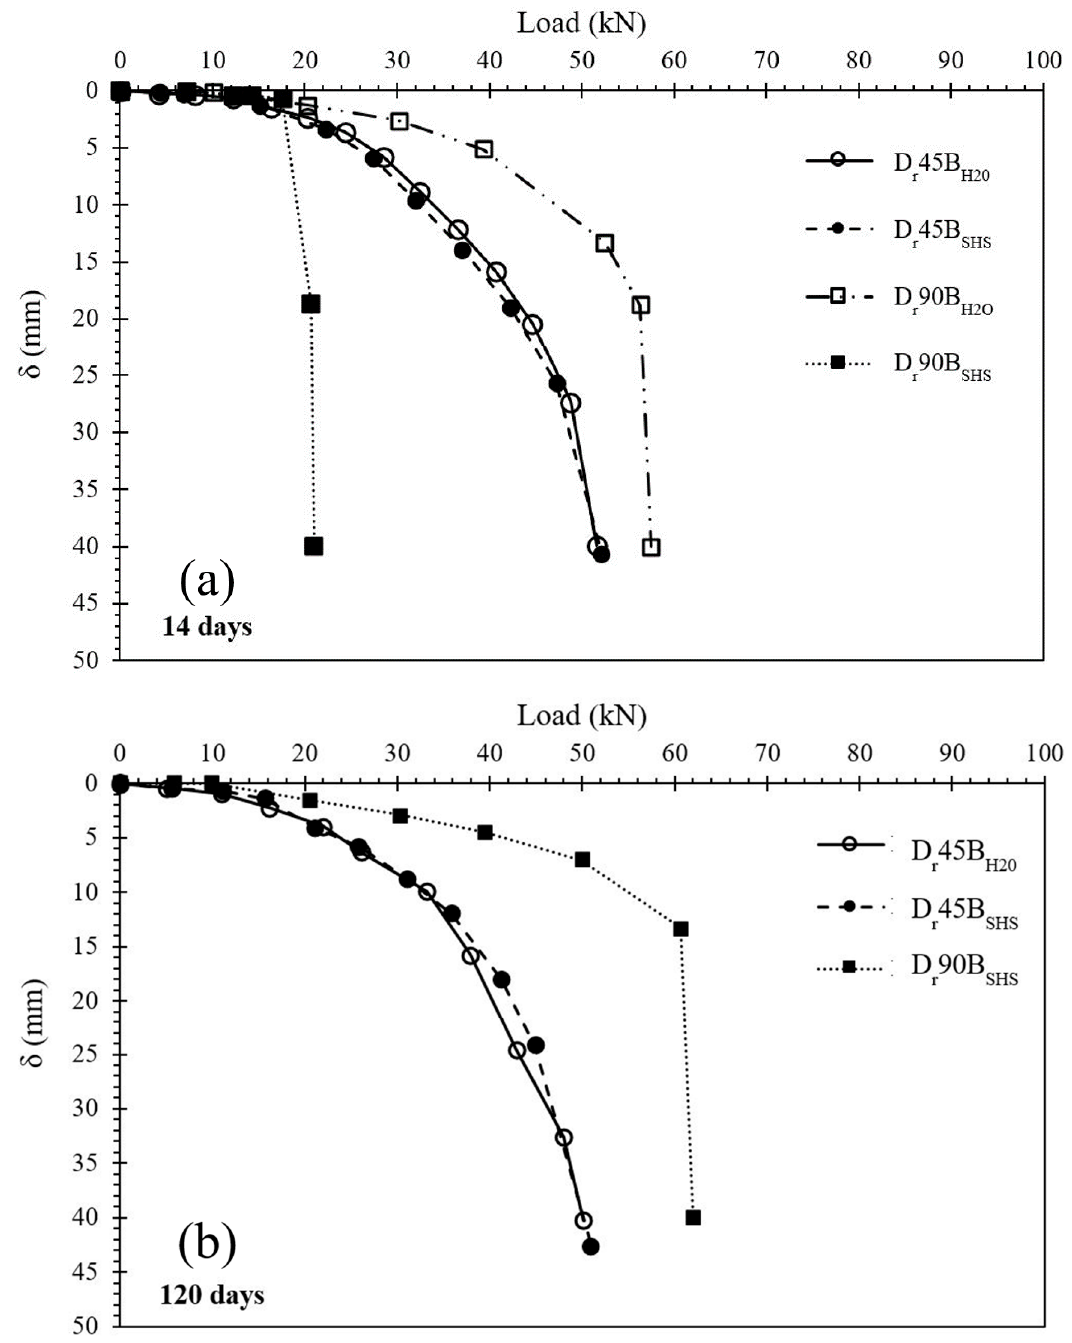
Figure 12. Load vs. settlement ( a ) Cured for 14 days; ( b ) Cured for 120 days. For better observation of the general trends verified in the two diameters used, the applied loads and the respective settlements were normalized by the area, and the resulting stress was then plotted as a function of the relative settlement ( δ /Dr ). Figure 13 shows that, after normalization, most curves are approximately superimposed, including that from the natural soil. The representation of the normalized results thus suggests that, re- garding the D r 450 mm tests, failure was controlled by the load capacity of the soil under- lying the stabilized layer. As the load increases, there is a progressive breaking of the bonds of the weakly cemented residual soil supporting the stabilized layers, resulting in the vertical penetration of the foundation with practically no lateral movement of the soil. This behavior is typically observed when structured soils lose their fabric [54]. The D r 900 mm layers reached the failure before the load capacity of the natural soil was exceeded (note that this capacity is higher than that of the foundation soil of the D r 450 mm layers), which justifies that the overlapping of the normalized 900 mm curves with the normalized 450 mm curves occurs only for an initial relative deformation of approximately 0.1%.